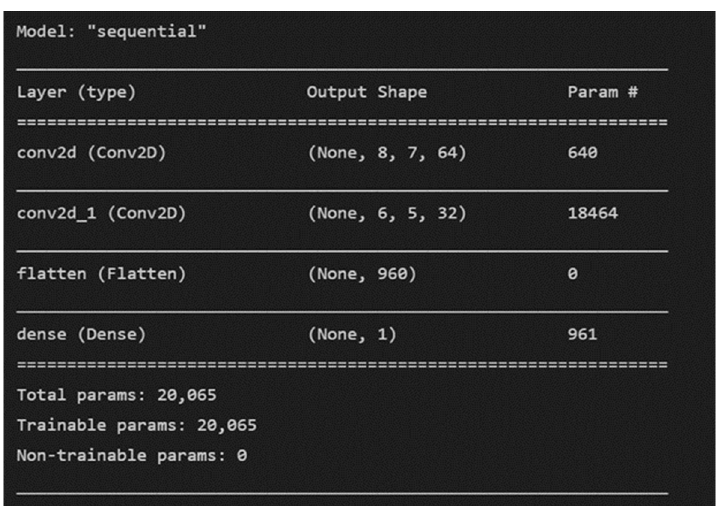
Figure 24. RUL prediction CNN model architecture.